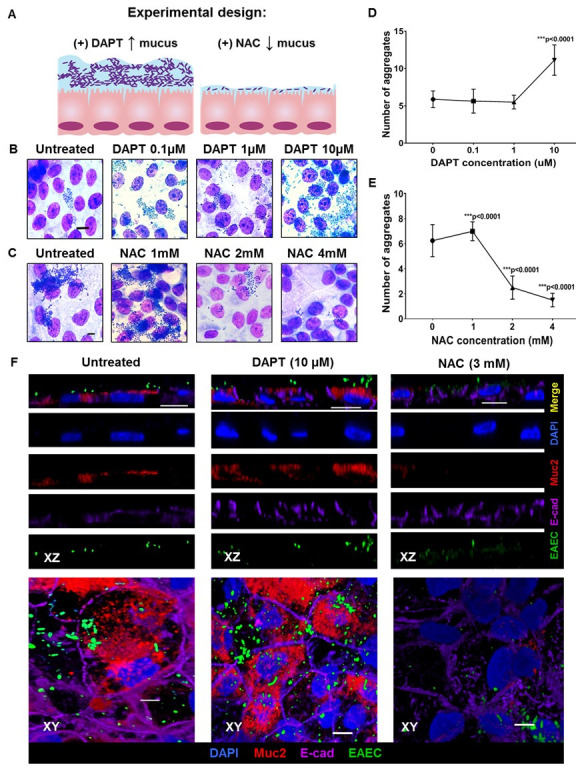
: EAEC adherence is dependent upon host intestinal mucus.(A) Experimental design explaining the chemical treatment performed to manipulate intestinal mucus and (B) showing increasing EAEC aggregative adherence to HIEMs with increased mucus production as induced by DAPT (a gamma secretase inhibitor). (C) EAEC clusters on HIEMs in the presence of N-Acetyl Cysteine (NAC), a mucolytic agent. (D-E) Quantification of EAEC aggregates in response to increasing doses of DAPT and NAC was quantified from average of 12 images taken at 100x and with field size of 2560x1920 pixel. Tukey’s multiple comparison test was performed, error bars denote SED and *** indicates significantly different (P<0.001). (F) shows representative confocal micrographs of HIEMs stained with fluorescent indicators for nuclei (DAPI, blue), MUC2 (Red), E-cadherin (Purple) and EAEC (GFP, green). HIEMs were infected with EAEC A2A:GFP that were treated with DAPT (10 μM) and NAC (3 mM). Representative of over 50 images. Scale bars indicate 10μm.